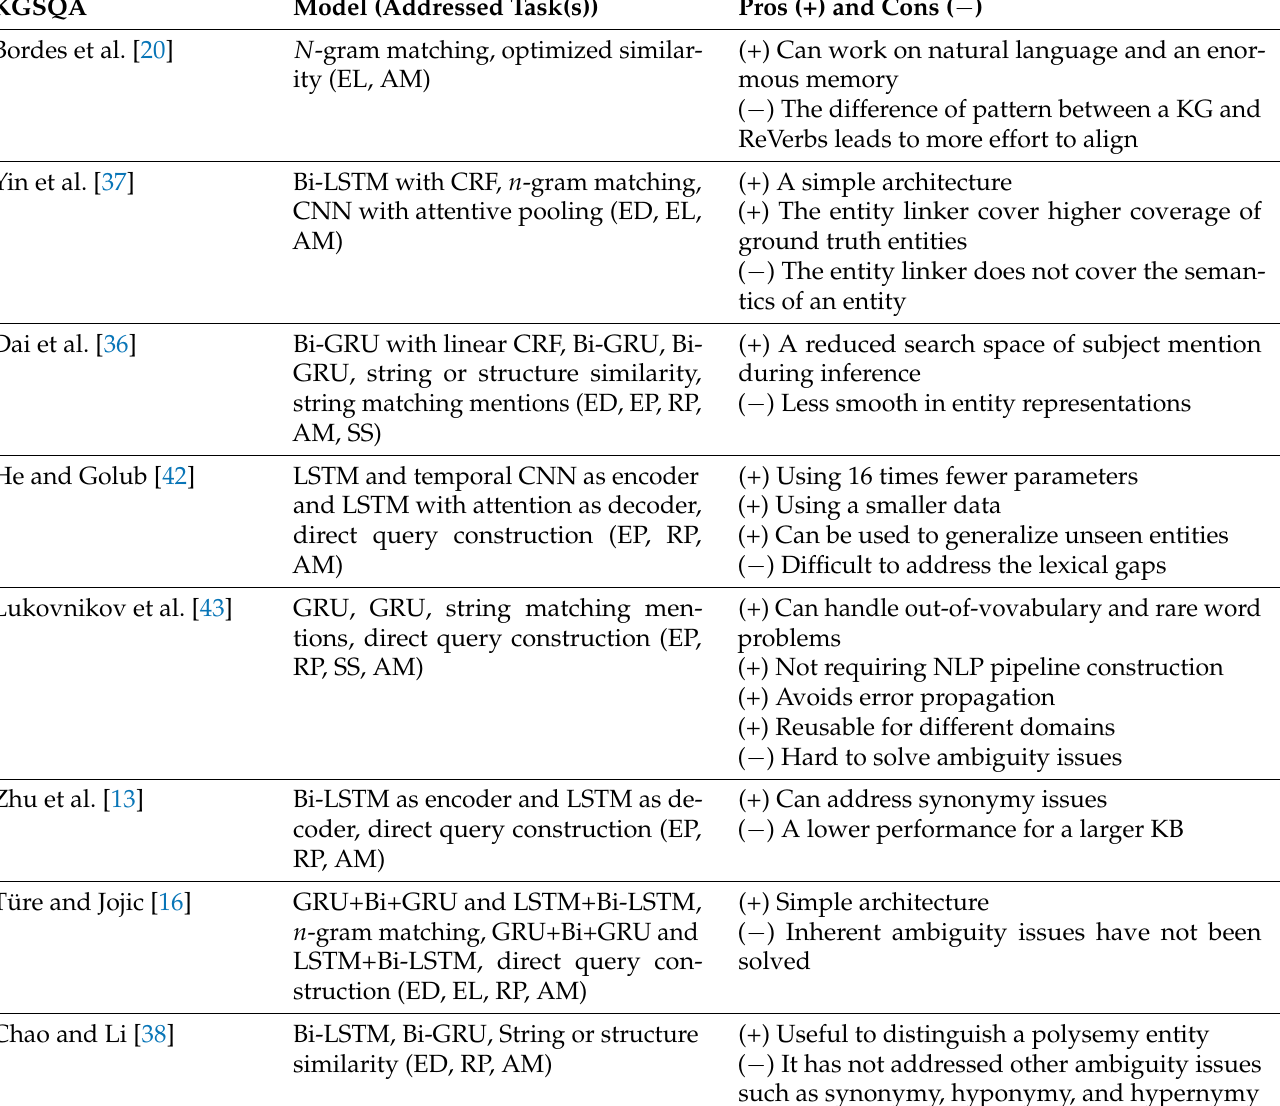
Table 4. KGSQA systems proposed from 2015 to 2018 and its strengths and